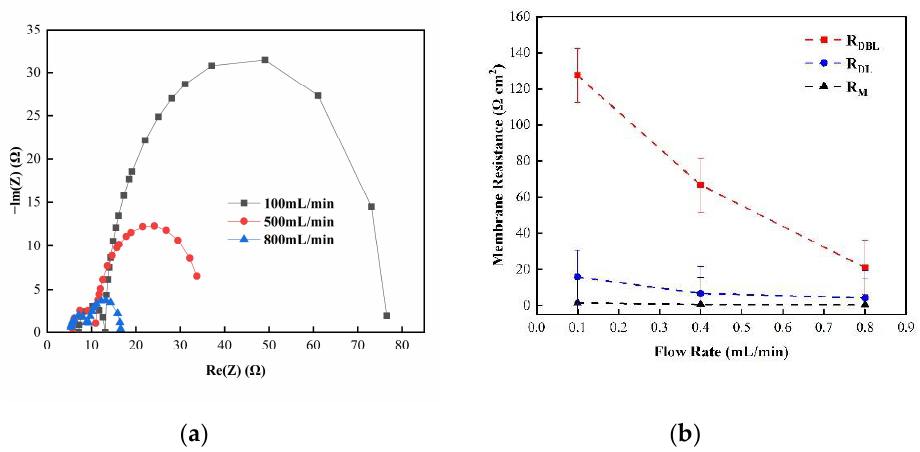
Figure 7. ( a ) The impedance of the Nyquist spectrum and ( b ) the membrane impedance (R M ), double layer impedance (R DL ), and diffusion layer impedance (R DBL ) of the CEM membrane in 0.05 M NaCl solution.